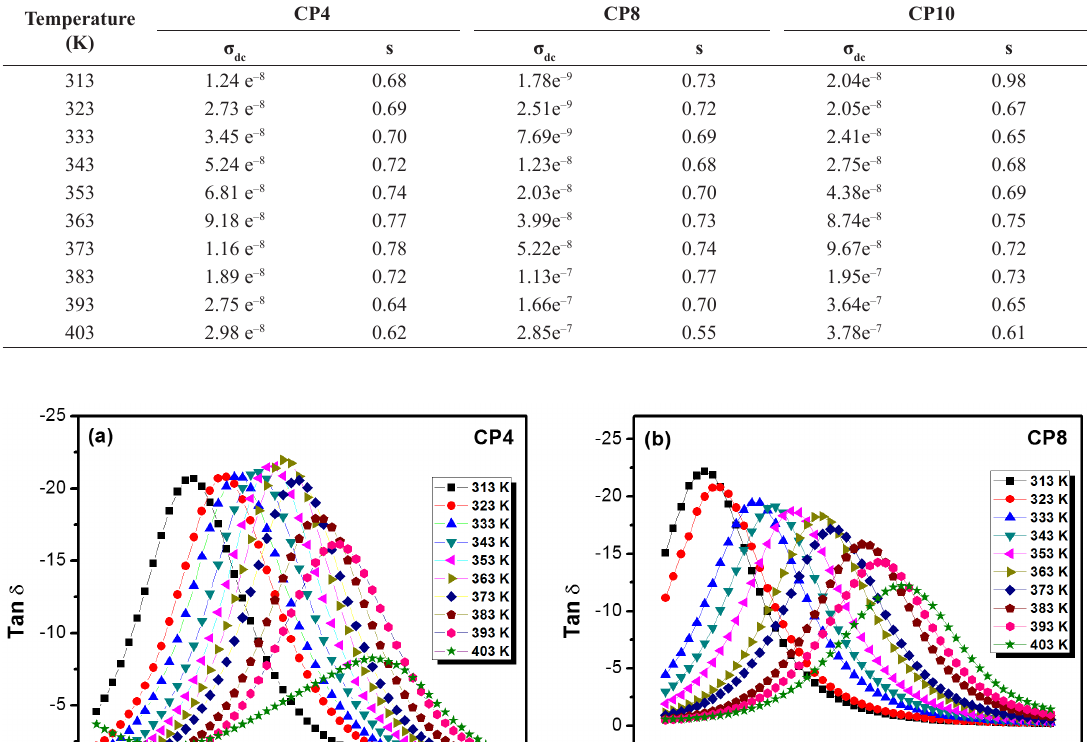
Table 2. Data of σ and s at different temperatures for the CP4, CP8 and CP10 blends. DC